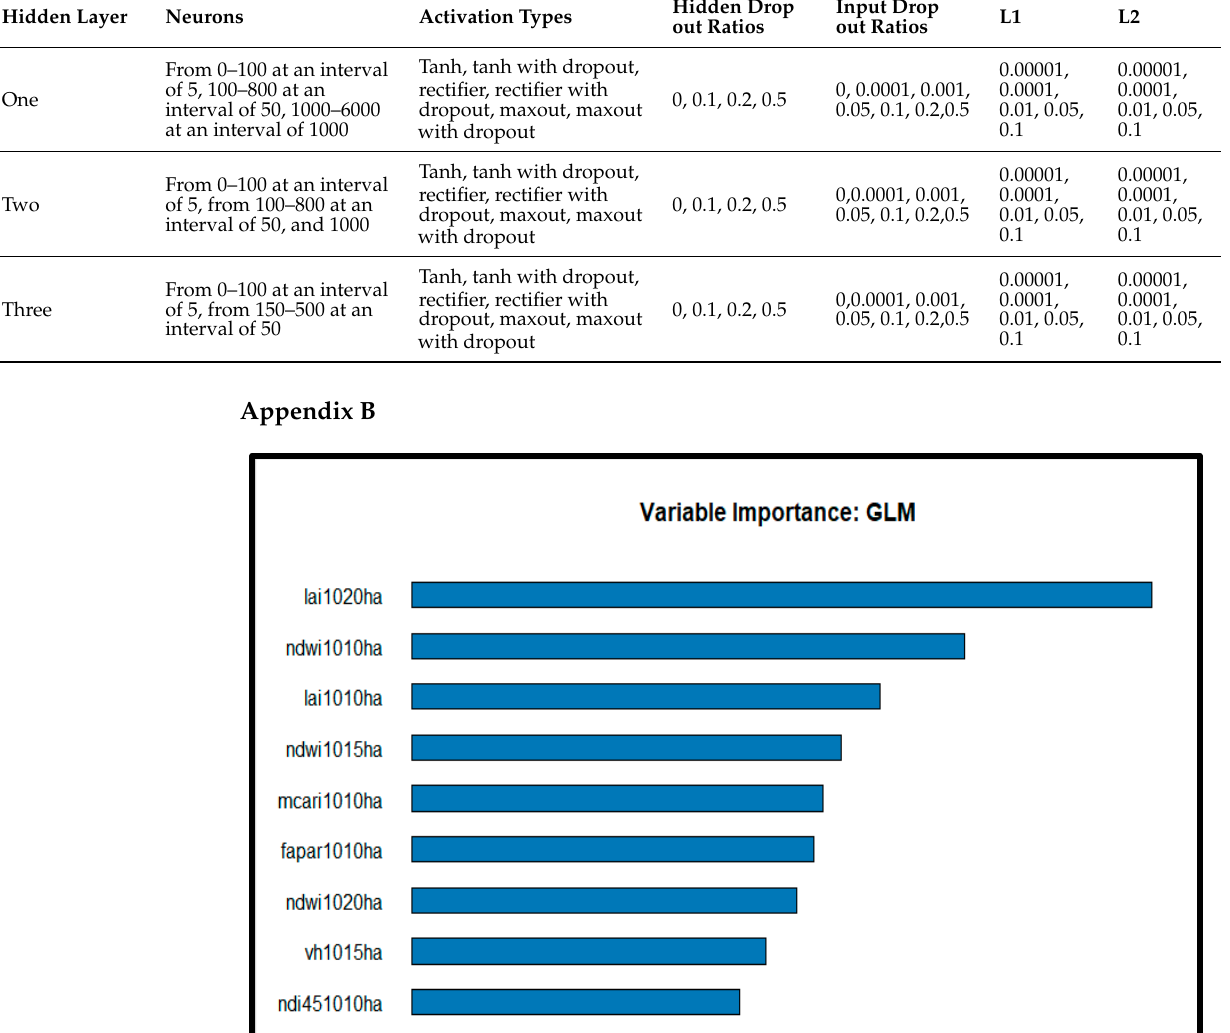
Table A1. Table showing hyperparameters tuned with their range of respective values applied in the study for deep learning models.